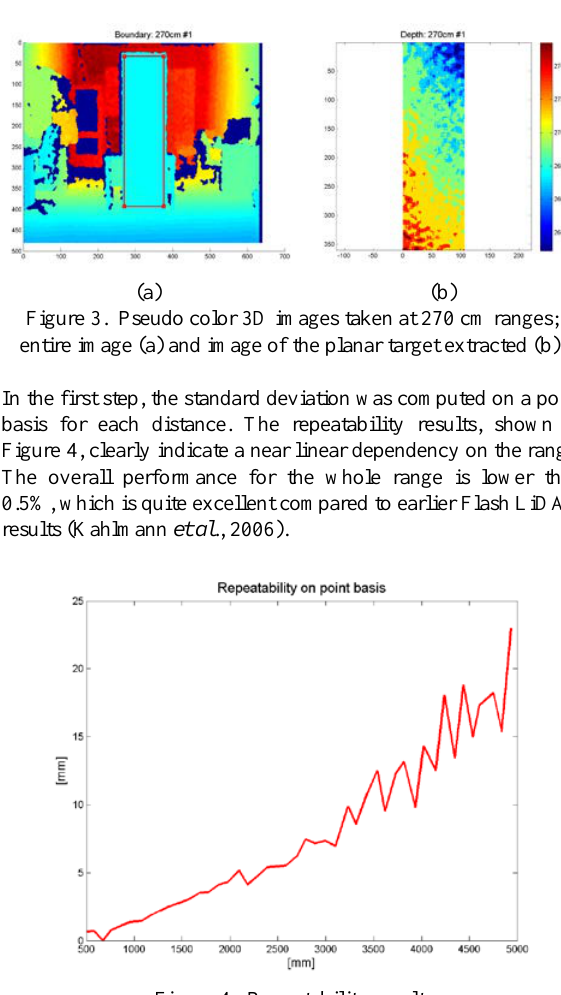
Figure 4. Repeatability result.